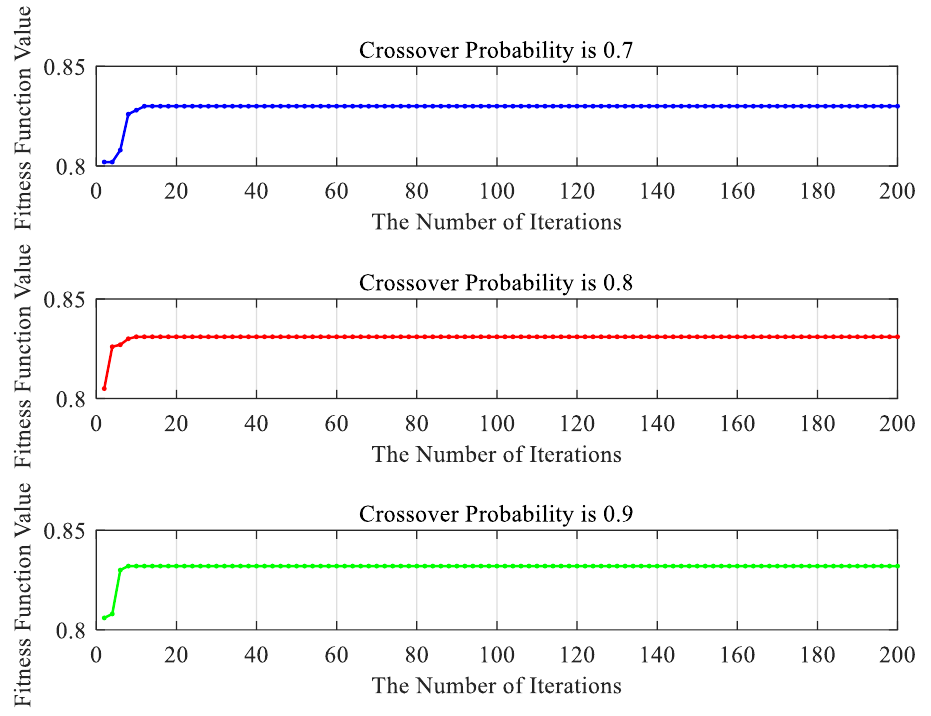
Figure 14. Influence of crossover operator on GA.